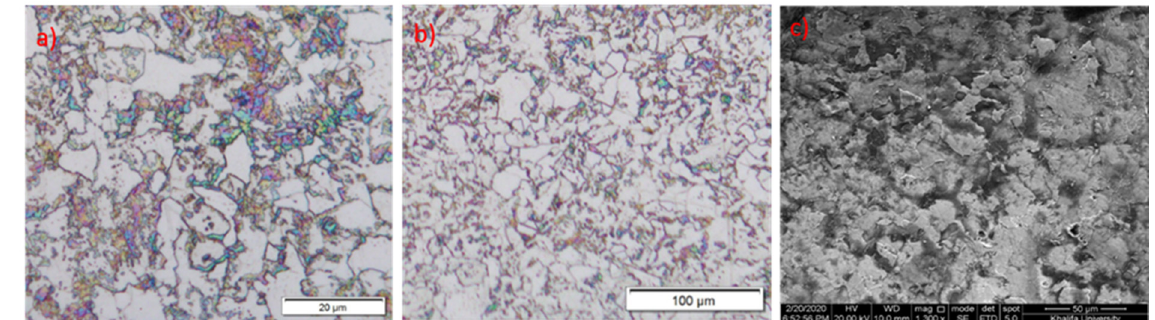
Figure 5. The microstructure of the steel is studied using optical microscopic images of the metal sample and shown ( a ) 20-micrometer ( b ) 100-micrometer ( c ) SEM images of the surface.